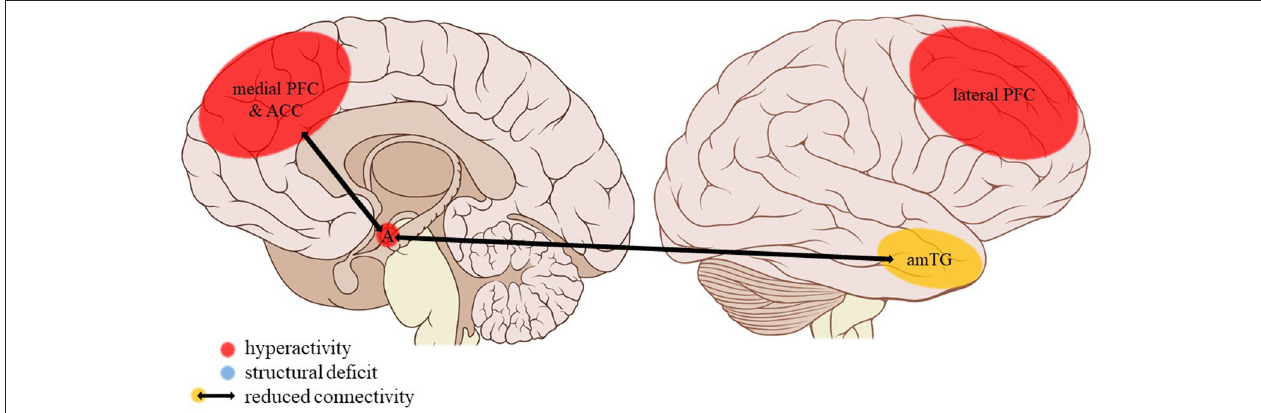
FIGURE 4 | Neuroimaging findings associated with EM. PFC, prefrontal cortex; ACC, anterior cingulate cortex; A, amygdala; amTG, anterior middle temporal gyrus. Adapted from: Patrick J. Lynch, medical illustrator; C. Carl Jaffe, MD, cardiologist. https://creativecommons.org/licenses/by/2.5/